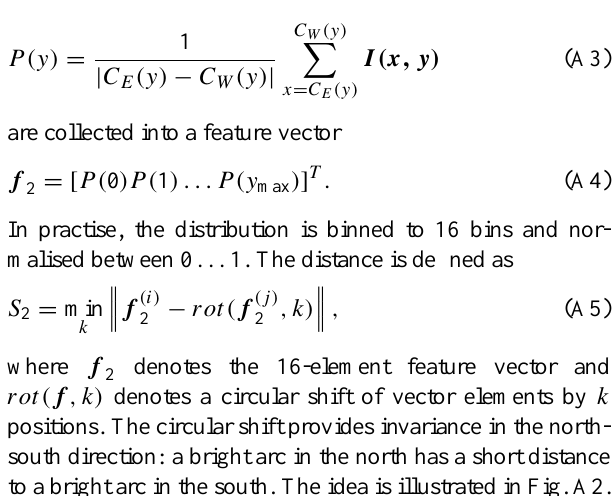
Fig. A2. The distance between two brightness distribution is the minimum distance obtained by circularly shifting one of the pro- files. Distribution 1 in the plot is a result of having an arc south of zenith and Distribution 2 is another arc but north of zenith. By shifting Distribution 2, we obtain a better match – smaller distance – with Distribution 1, which is desirable because both brightness distributions represent a single arc. Each distribution is binned into 16 bins before distance